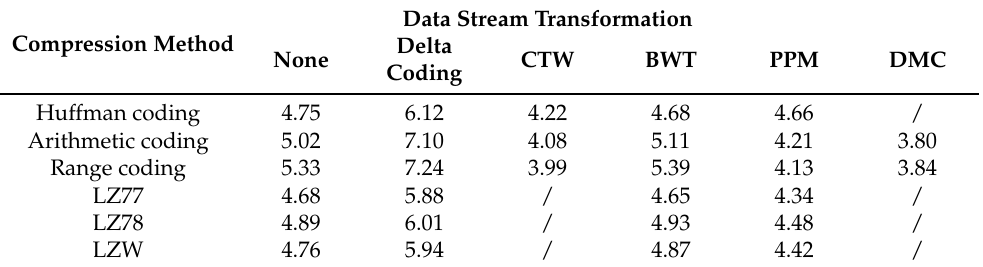
Table 8. AAE for possible combinations of data transformation and compression at binary tree structure